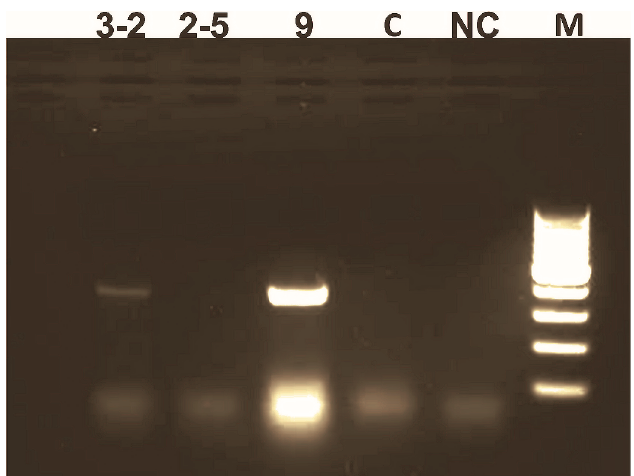
Figure 3. Analysis of the Sp-AMP2 gene expression in the transgenic tobacco plants by amplification of the gene-specific product from cDNA. Lane 3–2: transgenic T1 plants; lane 2–5: non-transgenic T1 plants; lane 9: T0 plants; lane C: control non-transgenic plants; lane NC: PCR without DNA template; lane M: 100 bp ladder.